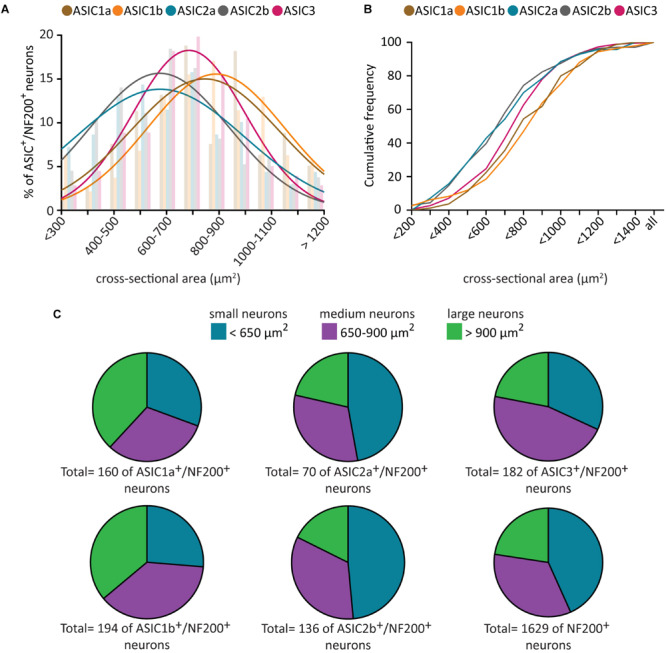
Size distribution analysis of ASICs/NF200-double positive neurons. Histogram (A) and cumulative curves (B) of the neuronal size distribution (bin = 100 μm2) of ASICs/NF200-double positive neurons in naïve adult mouse DRGs. Comparing to ASIC3/NF200-double positive neurons, the distribution curves of ASIC2a/NF200- and ASIC2b/NF200-double positive neurons were significantly shifted to the left (p < 0.01 for ASIC2a/NF200 and p < 0.01 for ASIC2b/NF200 using Extra sum-of-squares F-test). In contrast, the distribution curve of ASIC1b/NF200-, but not ASIC1a/NF200-double positive neurons, was significantly shifted to the right (p < 0.01 for ASIC1b/NF200 and p = 0.20 for ASIC1a/NF200 using Extra sum-of-squares F test). (C) Pie charts showing the distribution of ASICs/NF200-double positive neurons in three different groups: small-diameter (<650 μm2), medium-diameter (650–900 μm2), and large-diameter neurons (>900 μm2). 70–194 neurons from 4 to 11 DRGs from 4 mice.